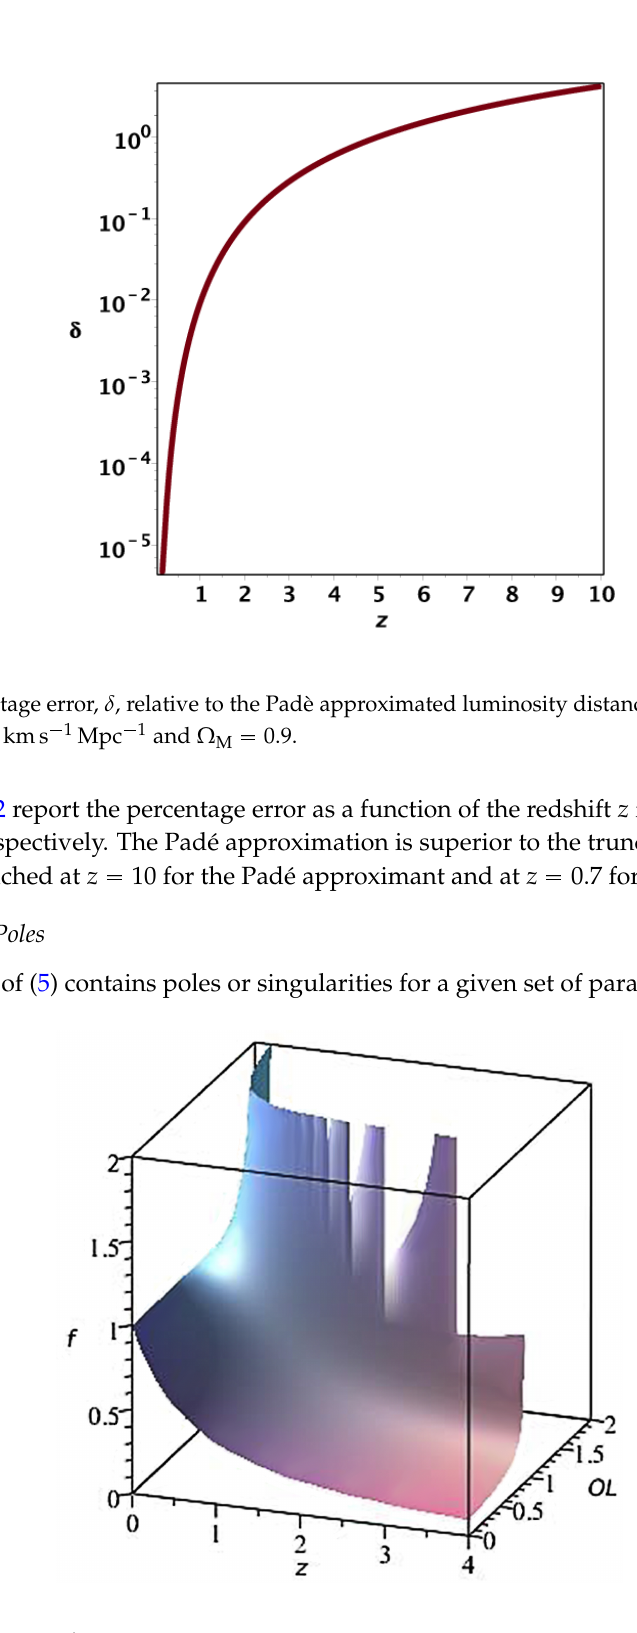
Figure 3. Behavior of